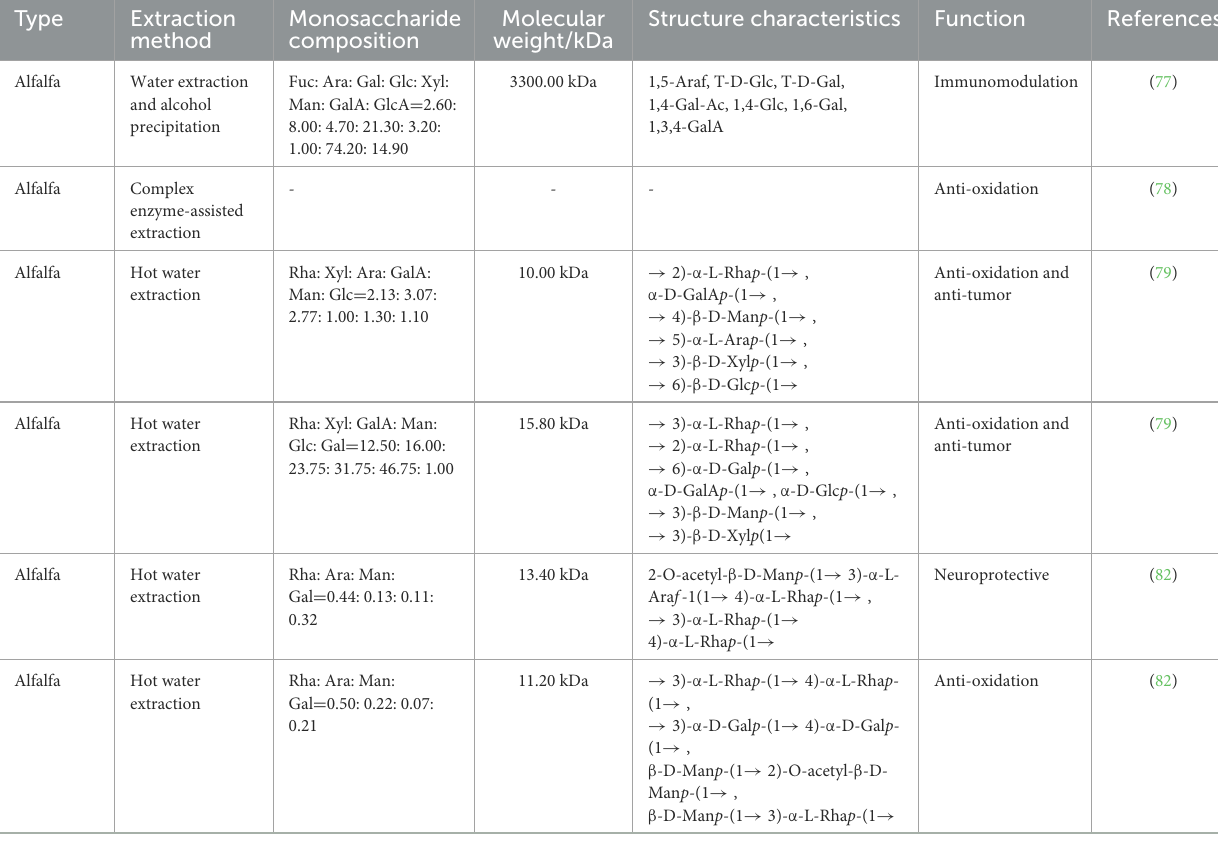
TABLE 4 Structure and structure-activity-relationship of polysaccharide from Alfalfa.